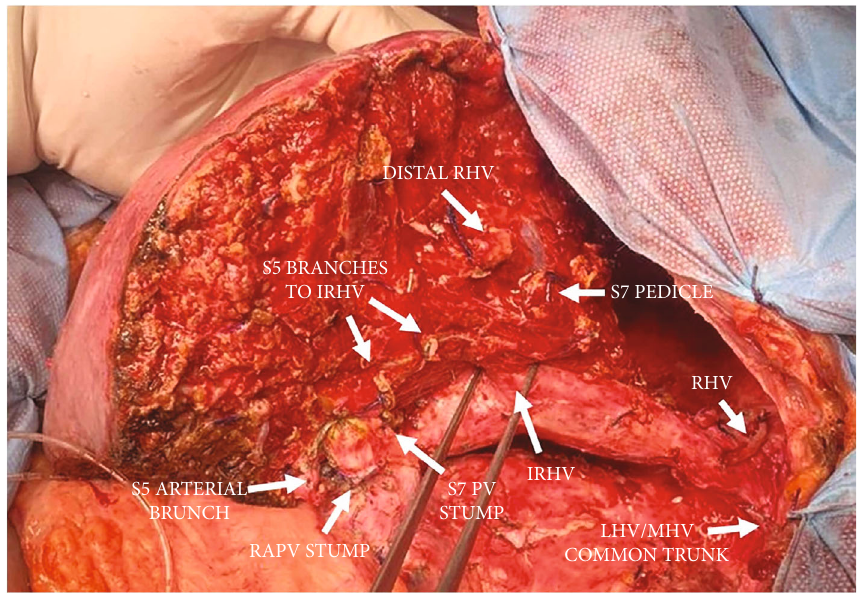
Figure 3: Intraoperative view of segment 6 remnant liver after resection (RHV: right hepatic vein; IRHV: inferior right hepatic vein; LHV: left hepatic vein; MHV: middle hepatic vein; S7 PV: segment 7 portal vein; RAPV: right anterior portal vein; S5: segment 5).